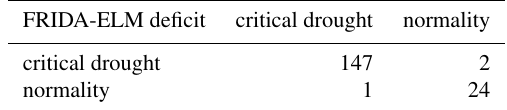
Table 6. FRIDA-ELM confusion